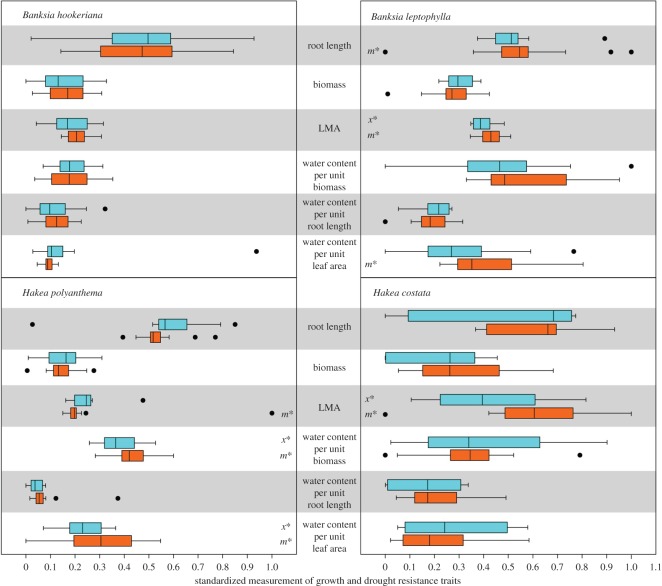
Standardized measurement of growth and physiological traits of seedlings derived from HiR (blue) and LoR (orange) populations in the glasshouse experiment under conditions of water deficit. Box indicates 25–75th percentile, black dots represent outliers. An ‘x’ with an asterisk indicates a significant difference in mean values and an ‘m’ with an asterisk indicates a significant difference in median values between HiR and LoR populations.